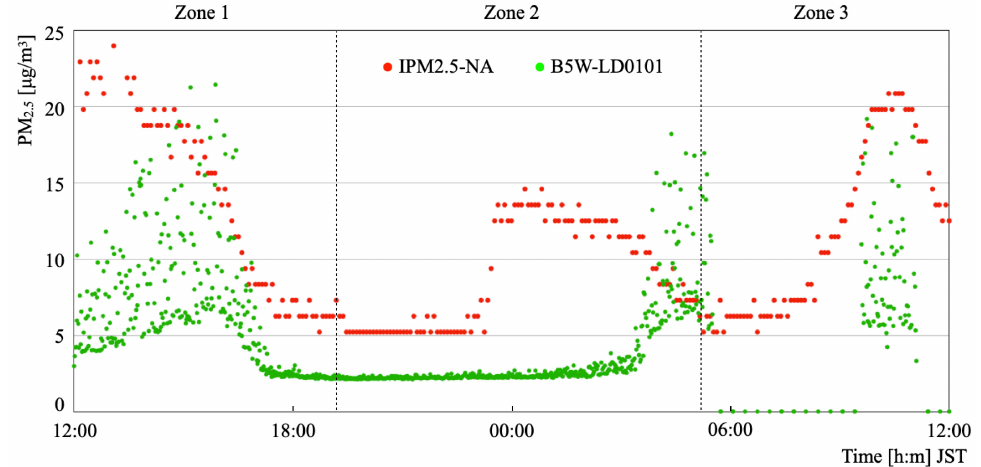
Figure 15. Output signals obtained during 24 h.